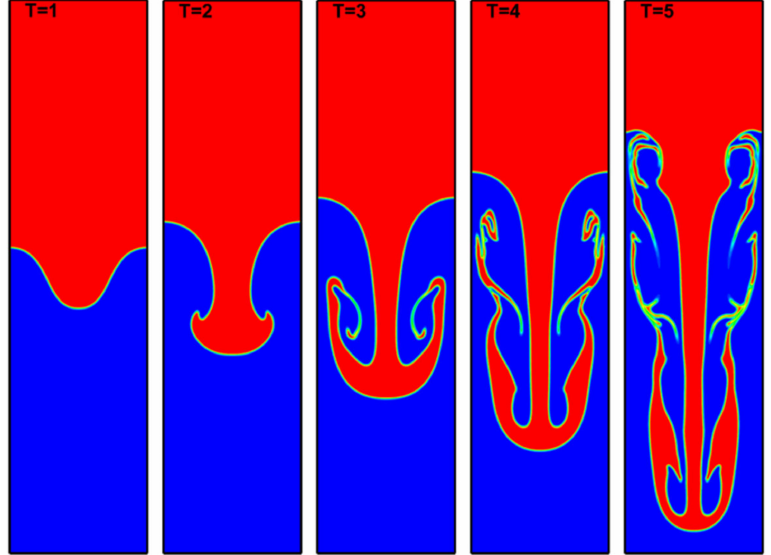
Figure 17. Development of the interface for the Rayleigh–Taylor instability of Re = 3000 with the present approach ( k 1 = 10).